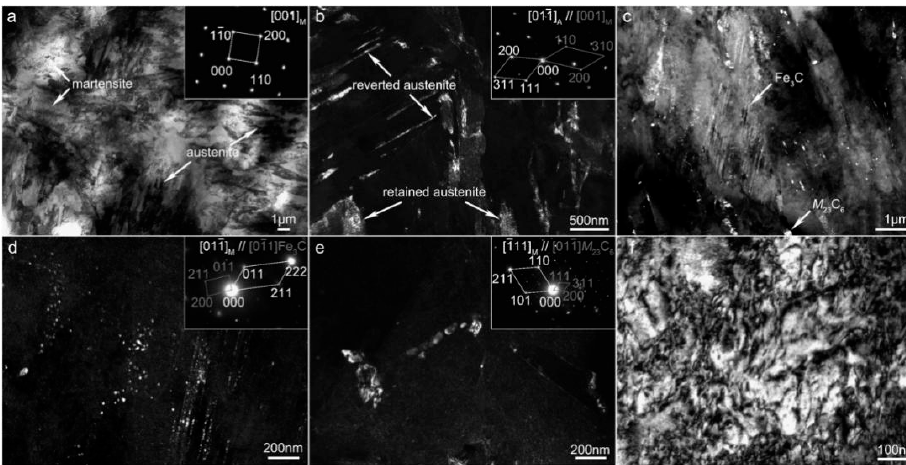
Figure 5. TEM analysis of the as-tempered specimens: ( a ) BF image; ( b ) DF image and the SAED pattern of austenite; ( c ) DF image of carbides; ( d ) DF image and the SAED pattern of Fe 3 C; ( e ) DF image and the SAED pattern of M 23 C 6 ; ( f ) dislocation.